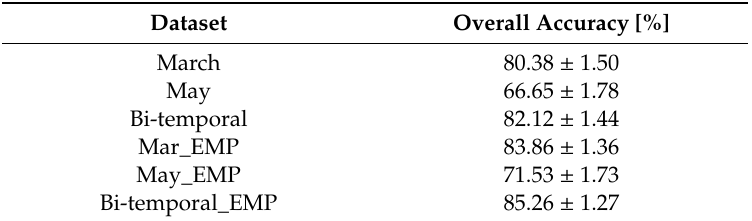
Table 3. Overall accuracy (%) with the 95% confidence interval